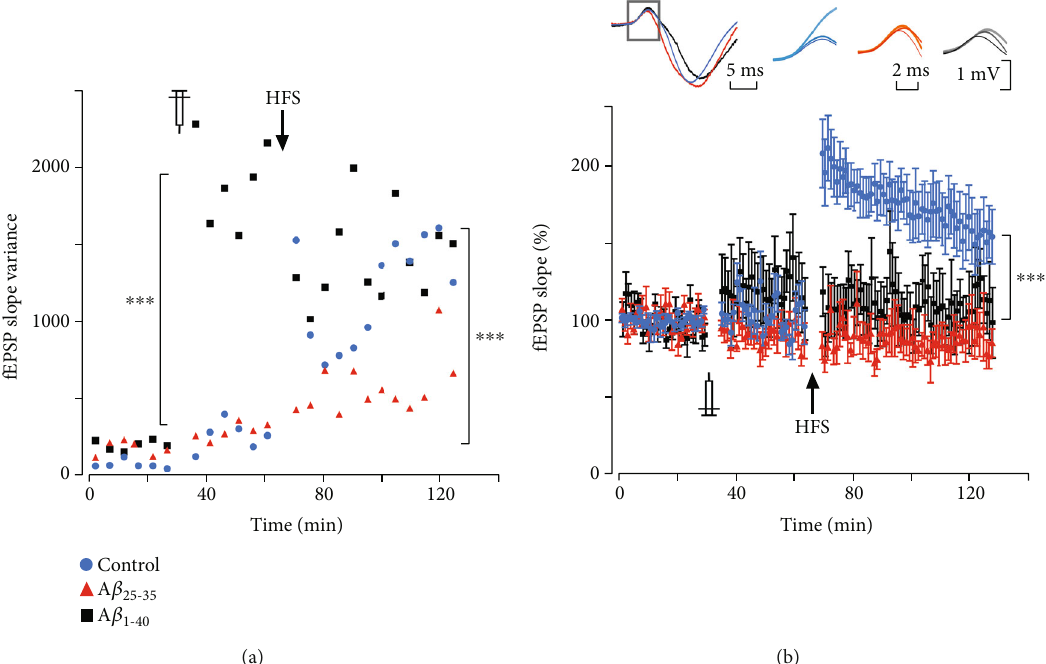
Figure 3: Intrahippocampal A β injections altered synaptic variability and impaired LTP in cCA3-to-CA1 synapse. Temporal evolution of slope variability (a) and magnitude (b) of cCA3 stimulation-evoked EPSP in CA1 recorded along three consecutive experimental stages, from left to right: (1) 30min before peptide injection (baseline), (2) 30 min after intrahippocampal injection, and (3) after HFS (six 1s, 100Hz trains, delivered every 60 s). EPSP variability increased after intrahippocampal injection, being signi fi cantly higher in the A β 1-40 group. HFS induced signi fi cant LTP in vehicle-injected subjects but not in A β -injected ones. In (a), each dot represents 5min variance of slope; in (b), each dot illustrates 2 min mean ± standard errorof themean (SEM). Inset in (b): left — representative whole CA1 fEPSP average from each experimental group evoked by I stimuli delivered in contralateral CA3 (the region representing the monosynaptic 50 component is outlined by a gray rectangular box); right — three sets of average traces (10 trials per average) of the monosynaptic component of cCA3 stimulation-evoked CA1 fi eld potential obtained during baseline (thin line, dark colour), after intrahippocampal injection (intermediate line, intermediate colour), and after HFS (thick line, light colour) for each experimental group (control, blue; A β 25- , red; and A β , black). ∗∗∗ Signi fi cant di ff erences between groups ( p < 0 : 001 ). Data from each experimental group were normalized 35 1-40 respecting the average value obtained during the last 15min of